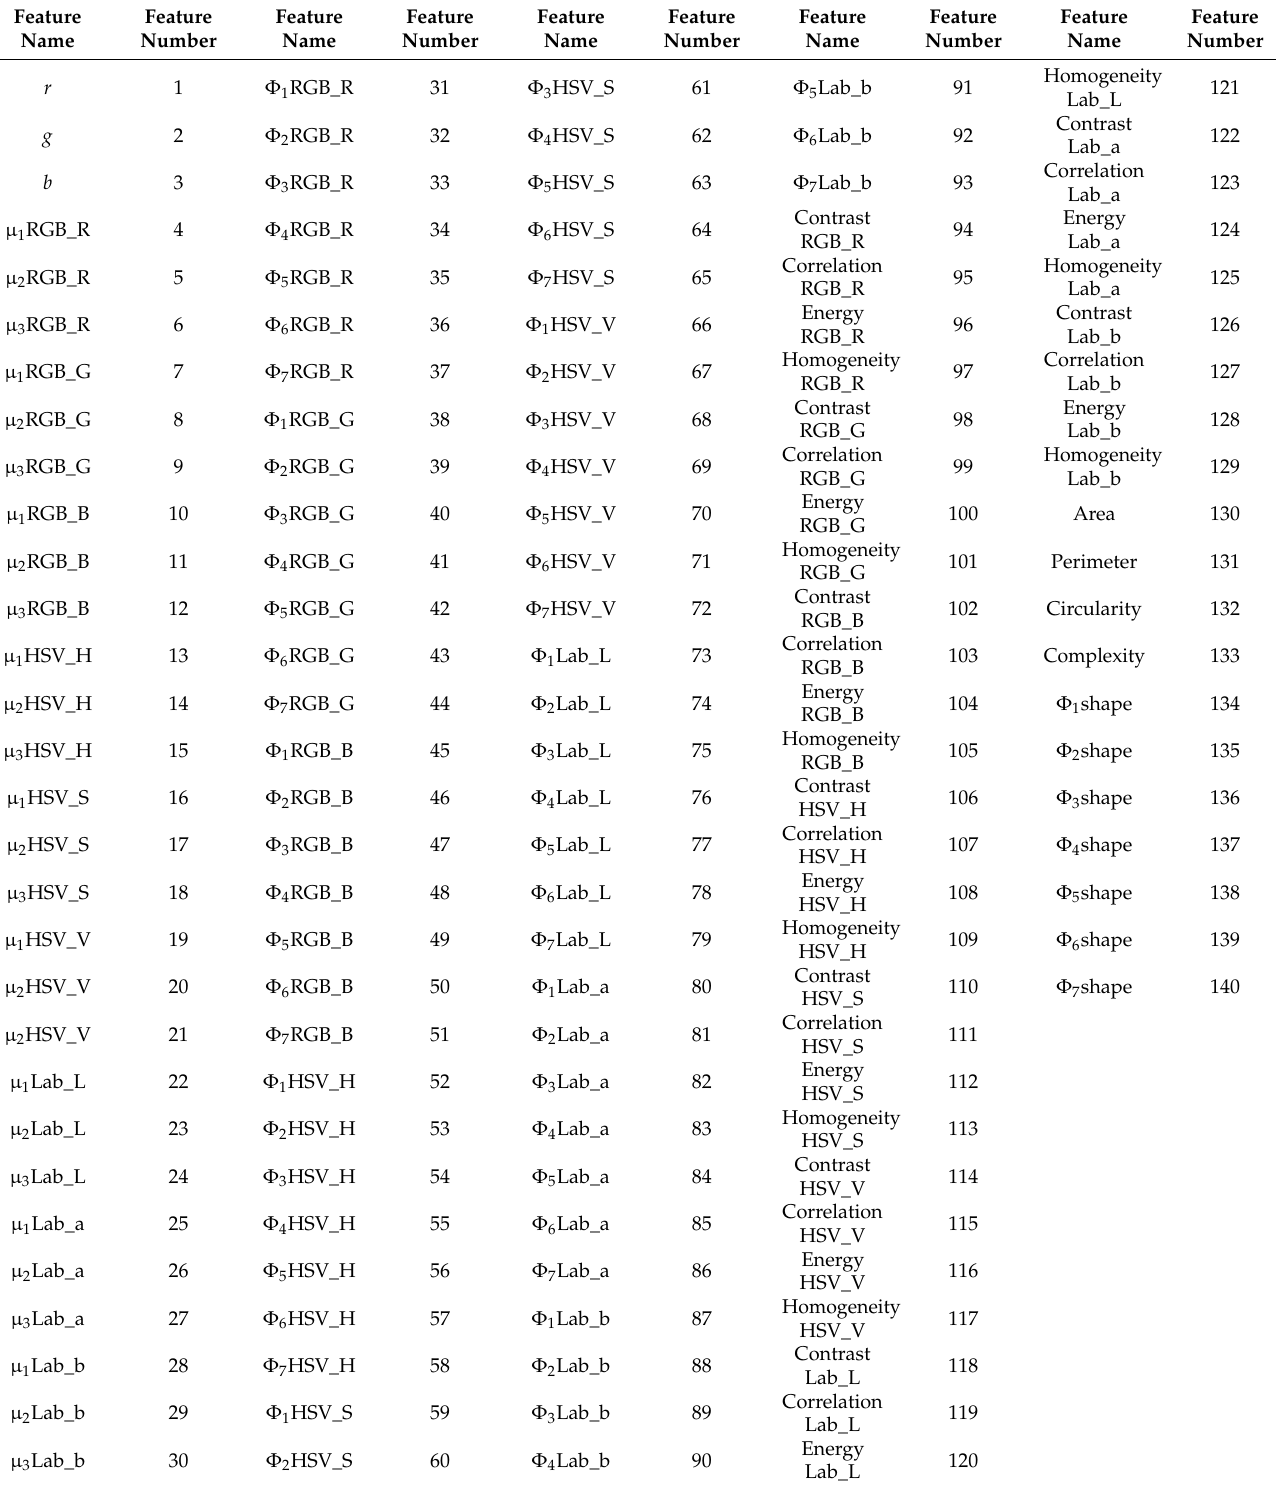
Table 2. Names and feature numbers of the color, texture, and shape features extracted in this